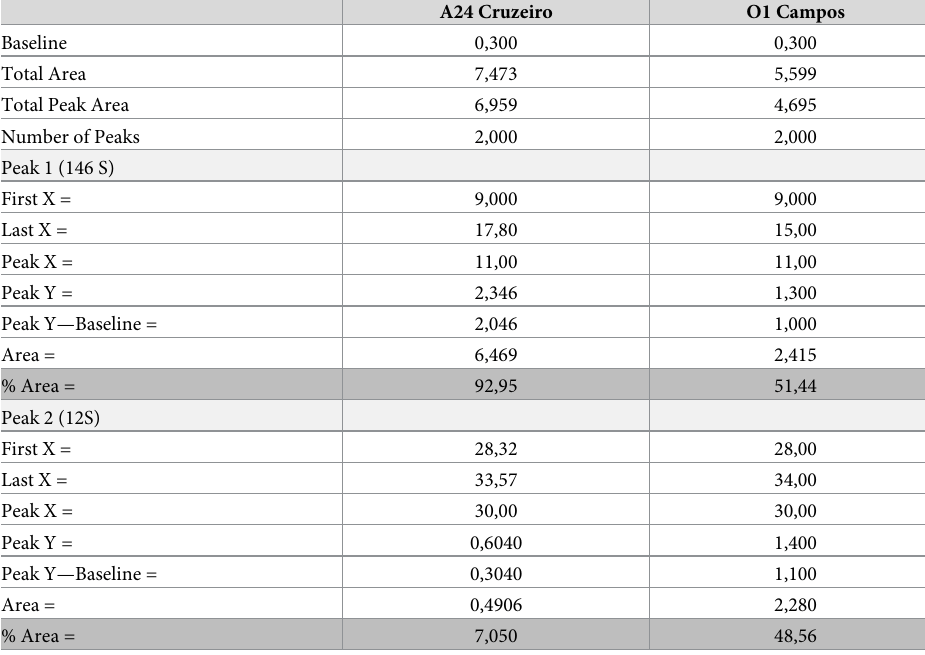
Table 1. Analysis of the area under the curve. Data from Fig